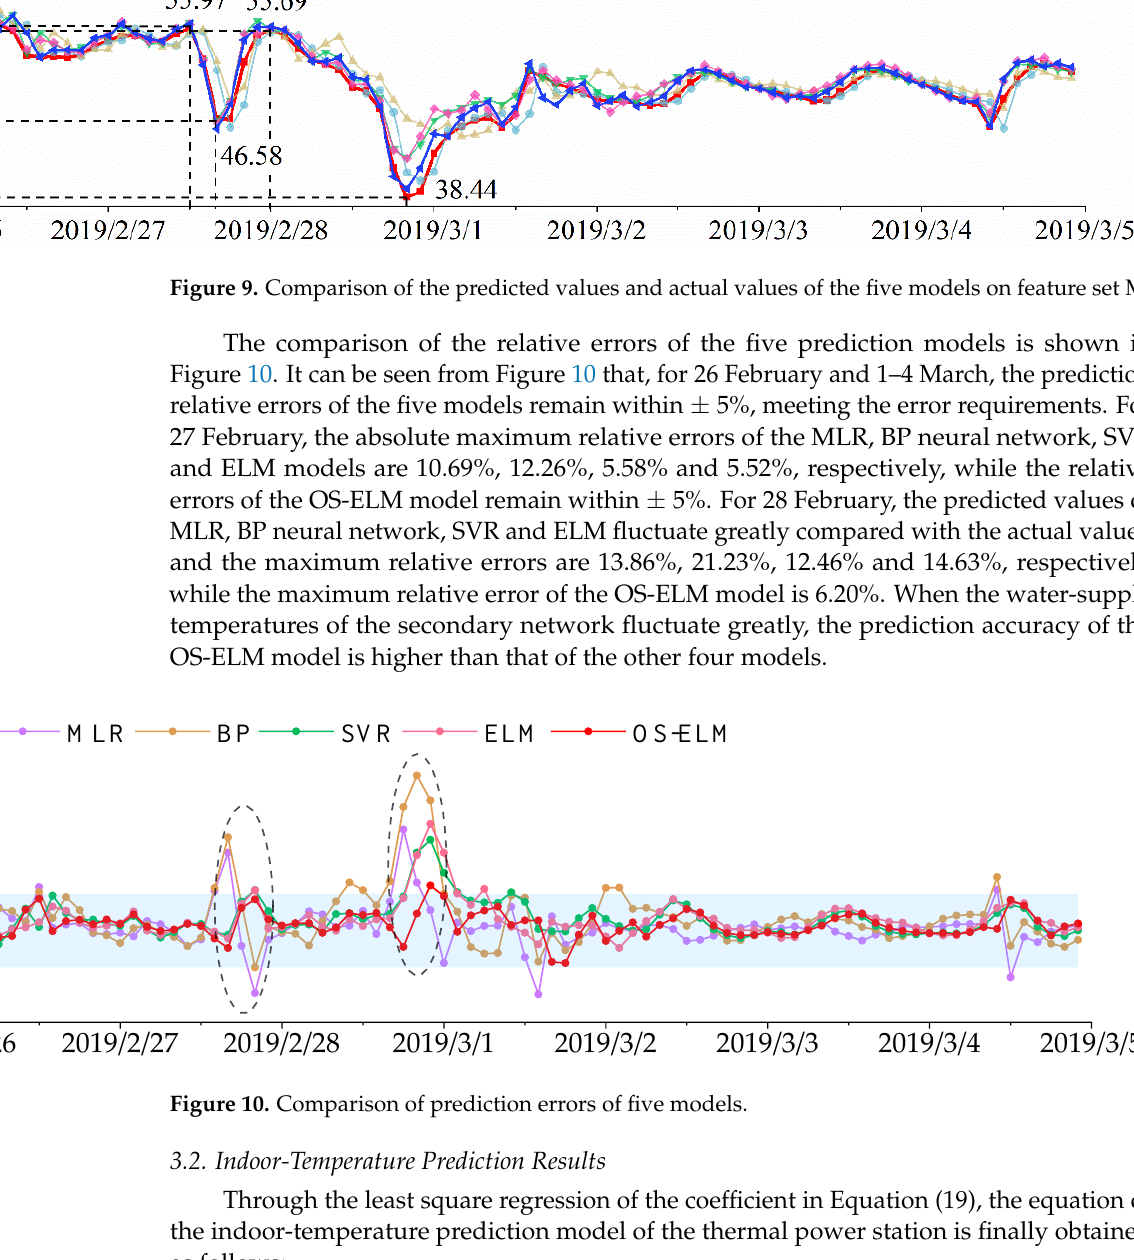
The prediction results of Equation (36) are compared with the actual indoor tempera- tures in Figure 11. It can be seen that the predicted values are in good agreement with the measured values. The minimum absolute error and maximum absolute error are − 0.22 ◦ C and 0.21 ◦ C. It can be considered that the prediction accuracy is acceptable to predict the indoor